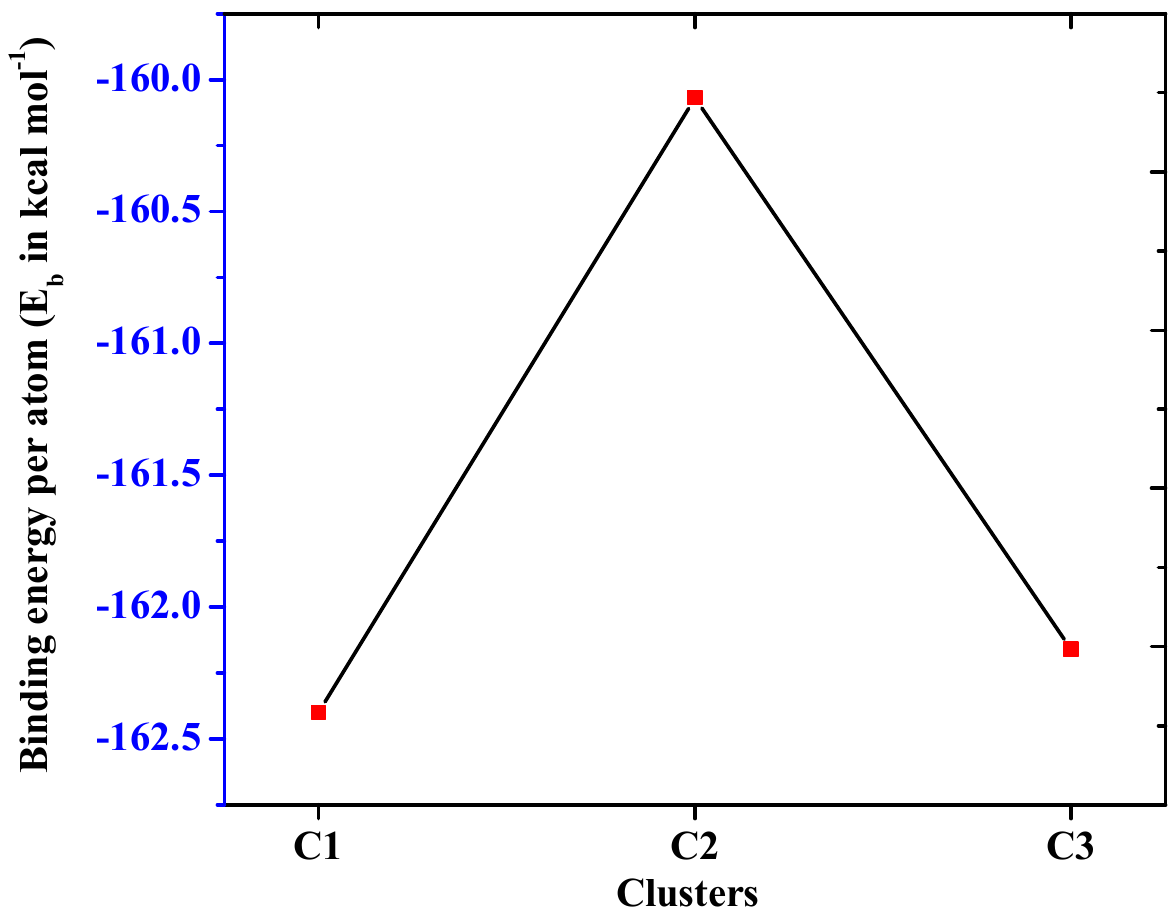
Figure 2. Binding energies per atom (E b ) of clusters.